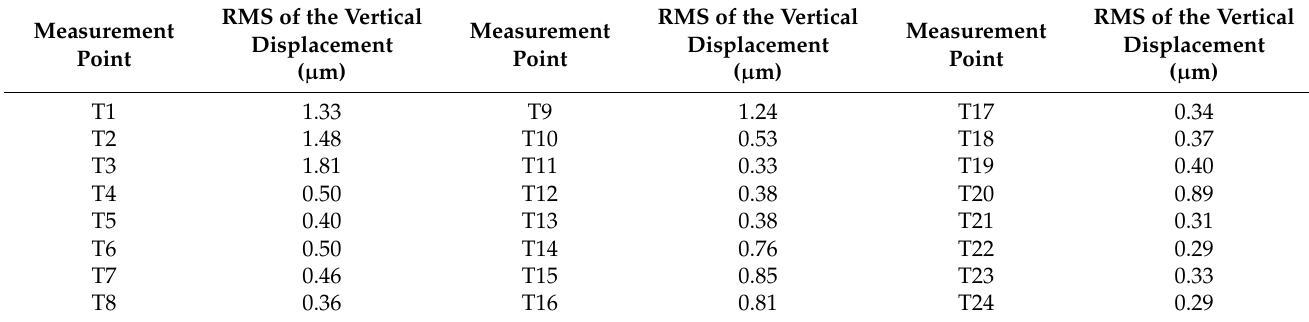
Figure 1. Map of Xiangjiaba Dam and Shuifu town and layout of the measurement points. Table 1. The RMS of the vertical displacement of measurement points.